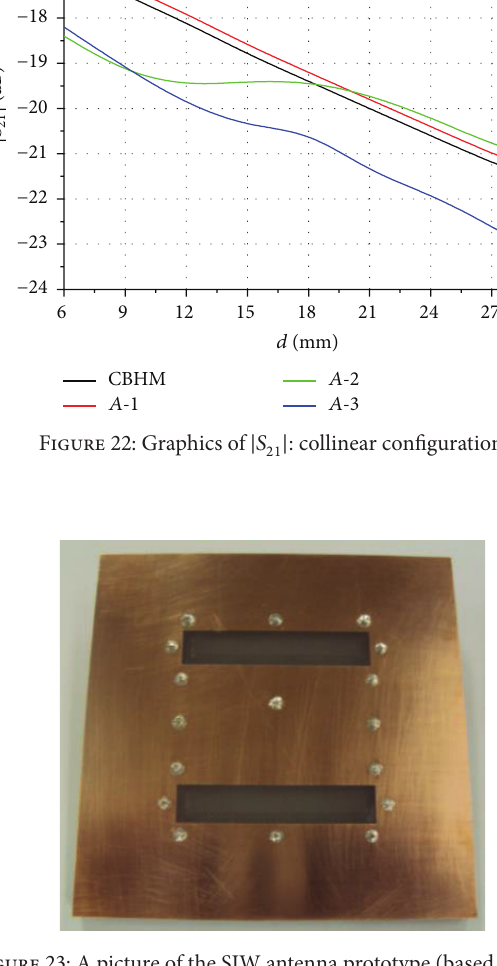
Figure 20: E -plane radiation patterns: collinear configuration.